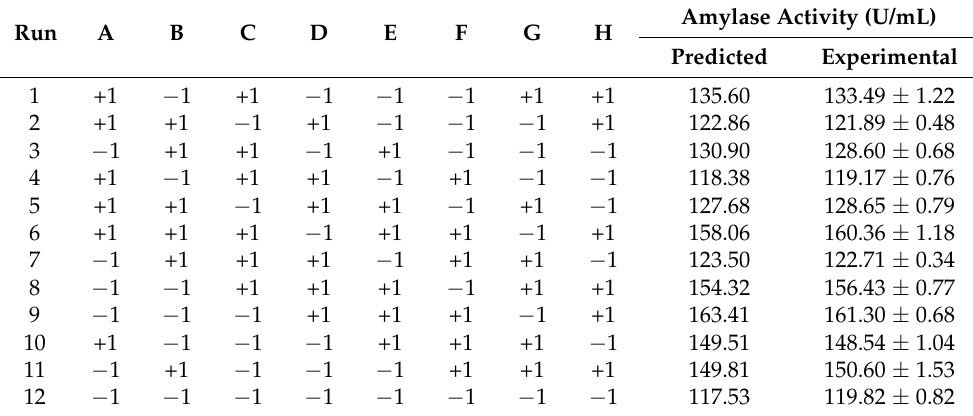
Table 2. Placket–Burman Design (PBD experimental design for screening and evaluating factors influencing amylase production from Bacillus sp.